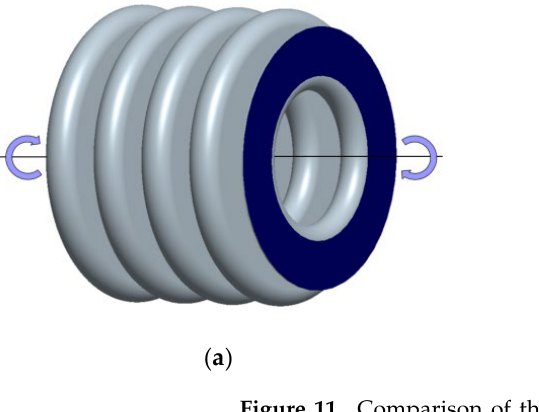
Figure 11. Comparison of the conditions of warping appearance; ( a ) no warping with circular cross-section; and ( b ) warping with non-circular cross-section.